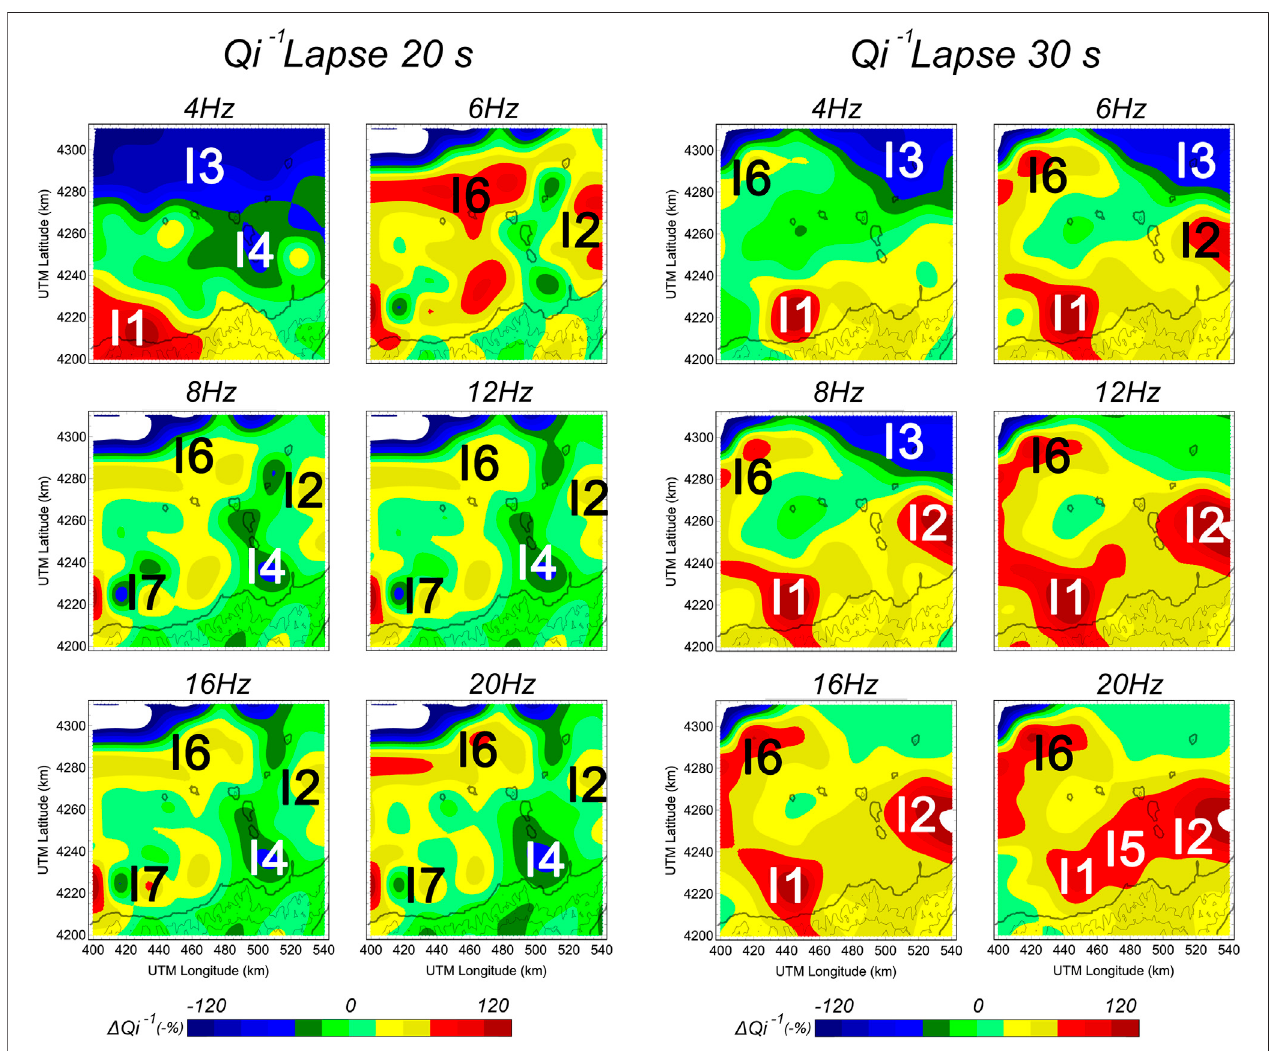
FIGURE 9 | Maps of intrinsic attenuation (represented by Qi − 1 ) for all analysed frequency bands. Maps are given for two lapse times: (A) 20 s and (B) 30 s.